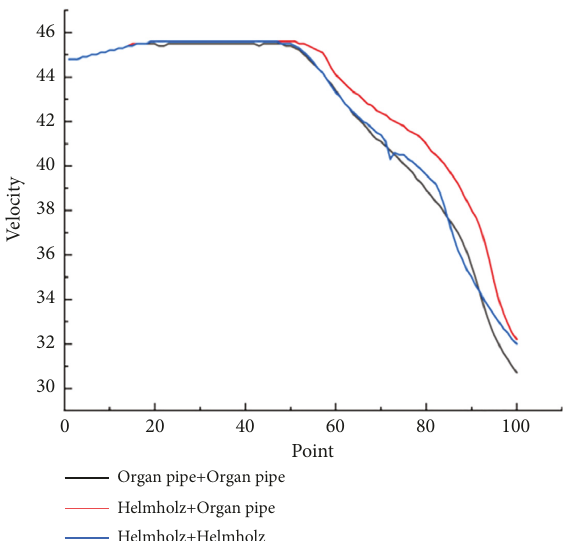
Figure 11: Velocity distribution of different dual-chamber self-excited oscillating pulsed nozzles.